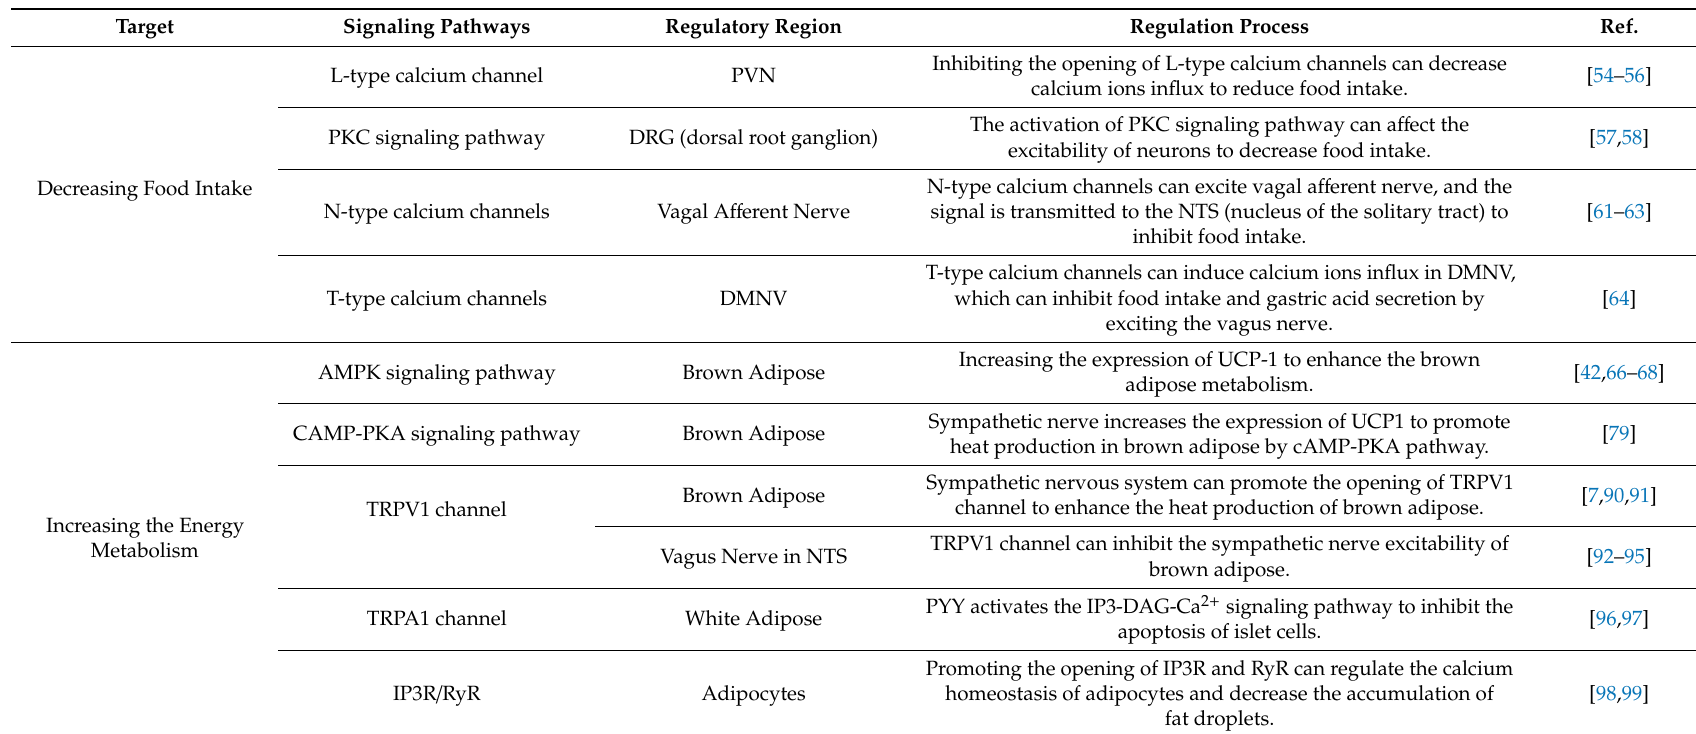
Table 2. The summary of the main calcium signaling pathways involved in the regulation of obesity by the nervous